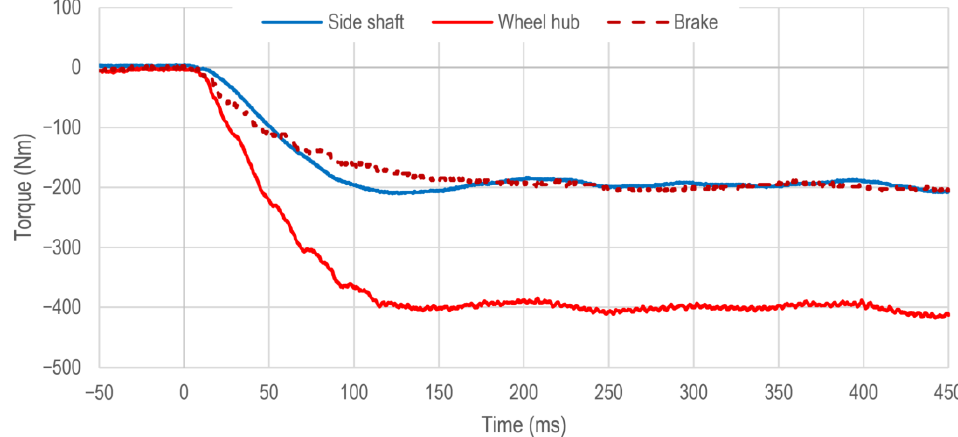
Figure 15. Braking operation with fixed 50/50 split between the drive machine and the conventional vehicle braking system from 25 km/h with activated prefilter and anti-jerk control.